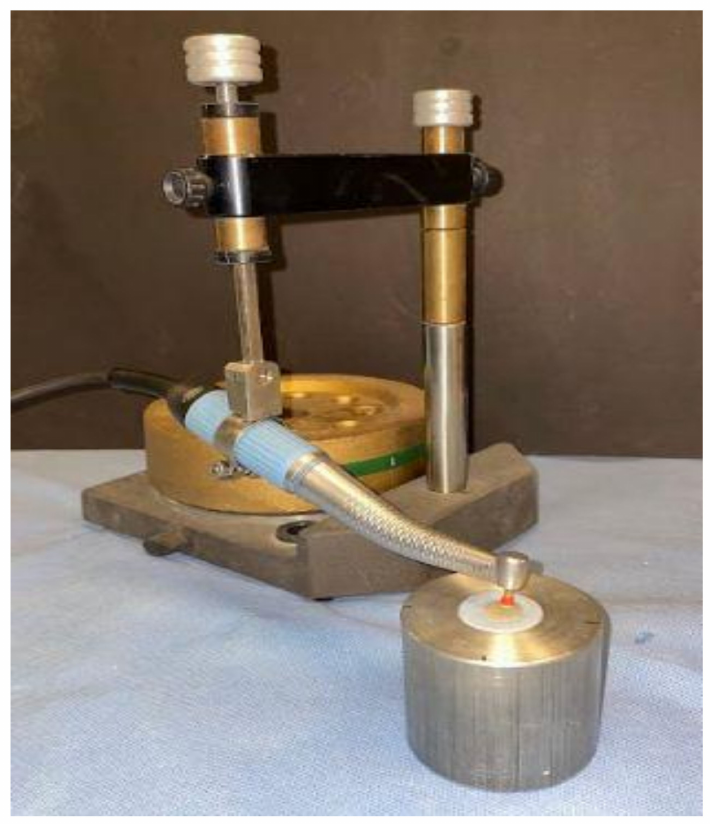
Figure 2. Customized holder used for surface